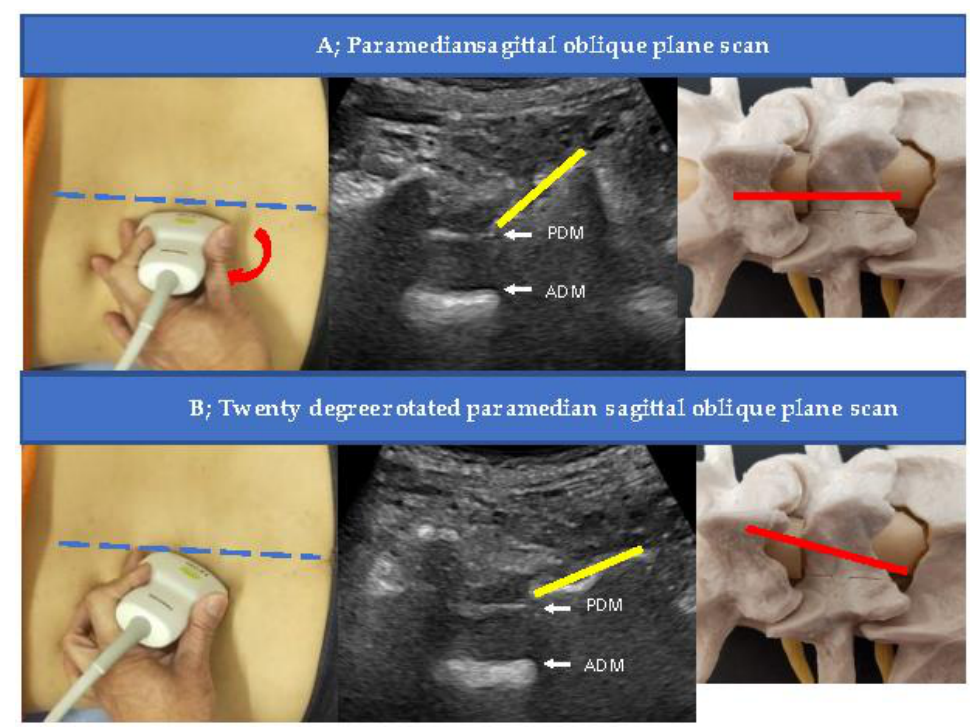
Figure 3. Direction of the probe during injection. The probe was rotated by 20° at the paramedian sagittal oblique plane to obtain the angle of the needle ( A ) to the obtuse dura mater and direct the needle tip to the midline, where the epidural fat layer is thickest at the lesion ( B ). The yellow line indicates the L5 lamina. Abbreviations: ADM, anterior dura matter; PDM, posterior dura matter. A completely aseptic technique was used during the procedure. First, the skin was disinfected using a chlorhexidine solution, which remained on the skin for at least 2 min to kill bacteria causing deep tissue infections following skin puncture (Figure 4A). After visualizing the ligamentum flavum, which had low echogenicity due to anisotropy, and